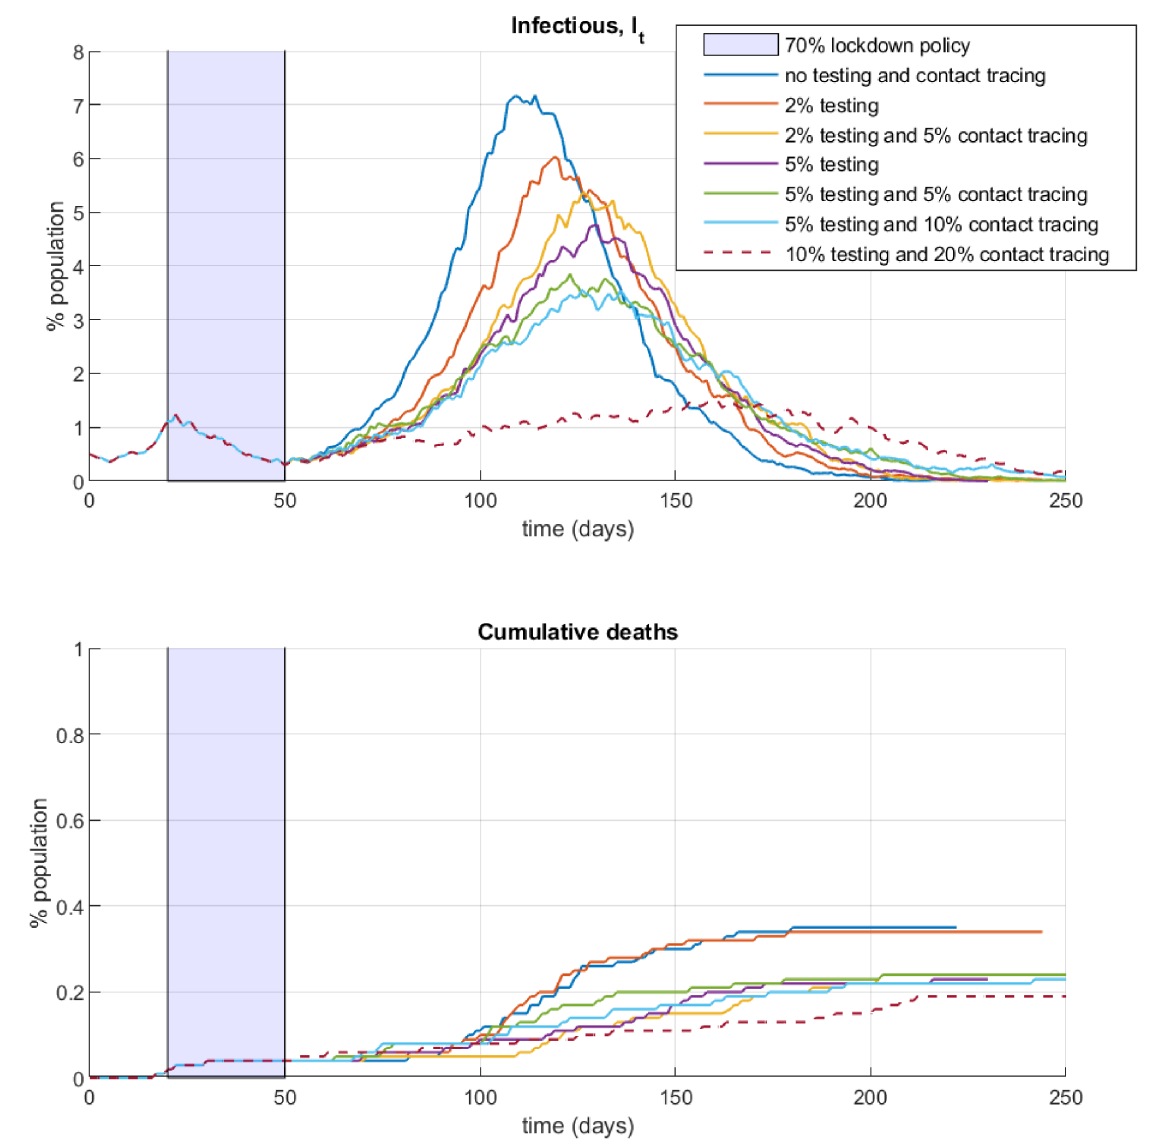
Fig 9. Lockdown exit, testing and contact